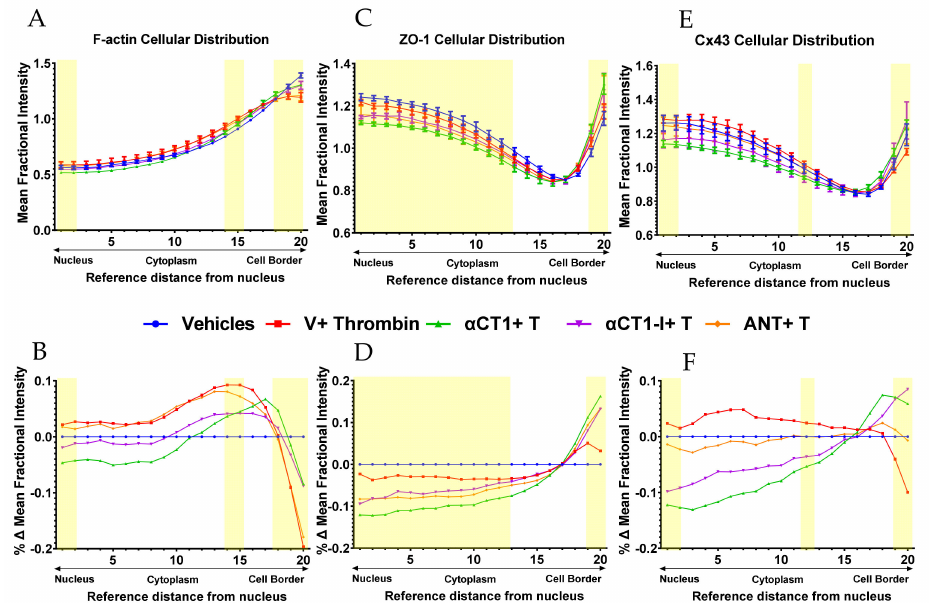
Figure 8. Quantification of α CT1 inhibition of thrombin-induced shift in endothelial F-actin distribu- tion in association with ZO1 and Cx43 remodeling in HDMECs. ( A , C , E ) The radial distributions of F-actin (top left) and ZO1 (top middle) and Cx43 (top right)) were measured as the mean fractional intensity at a given cell radius, calculated as fraction of total intensity normalized by fraction of pixels at a given radius. Cell diagram of regions 1–20 indicated in top left figure. ( B , D , F ) F-actin (bottom left) and ZO1 (bottom middle) and Cx43 (bottom right), vehicle-subtracted values calculated as percentage difference from vehicle 100% (Value-Vehicle)/Vehicle). N = 3. Yellow highlighted bar indicates where α CT1+T, but not α CT1-I+T or ANT+T is significant compared to thrombin